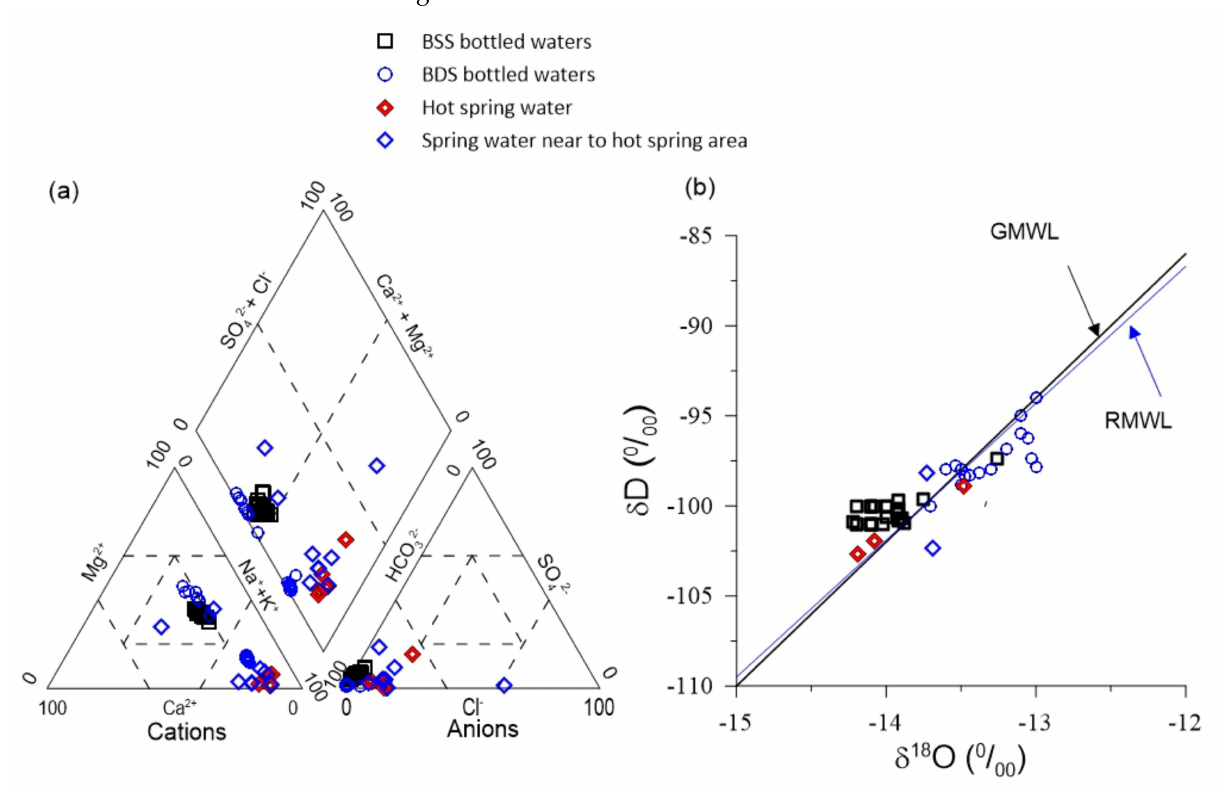
Figure 2. ( a ) Piper diagram showing compositions of the bottled waters, hot spring waters and stream waters near to the Mt. Baekdu area and ( b ) isotopic composition ( δ D and δ 18 O) of the two bottled waters in this study. GMW and RMWL represent the global meteoric water line [33] and the regional meteoric water line [34], respectively. The data of hot spring water and cold spring waters were used from this study (Table S1) and Han and Huh